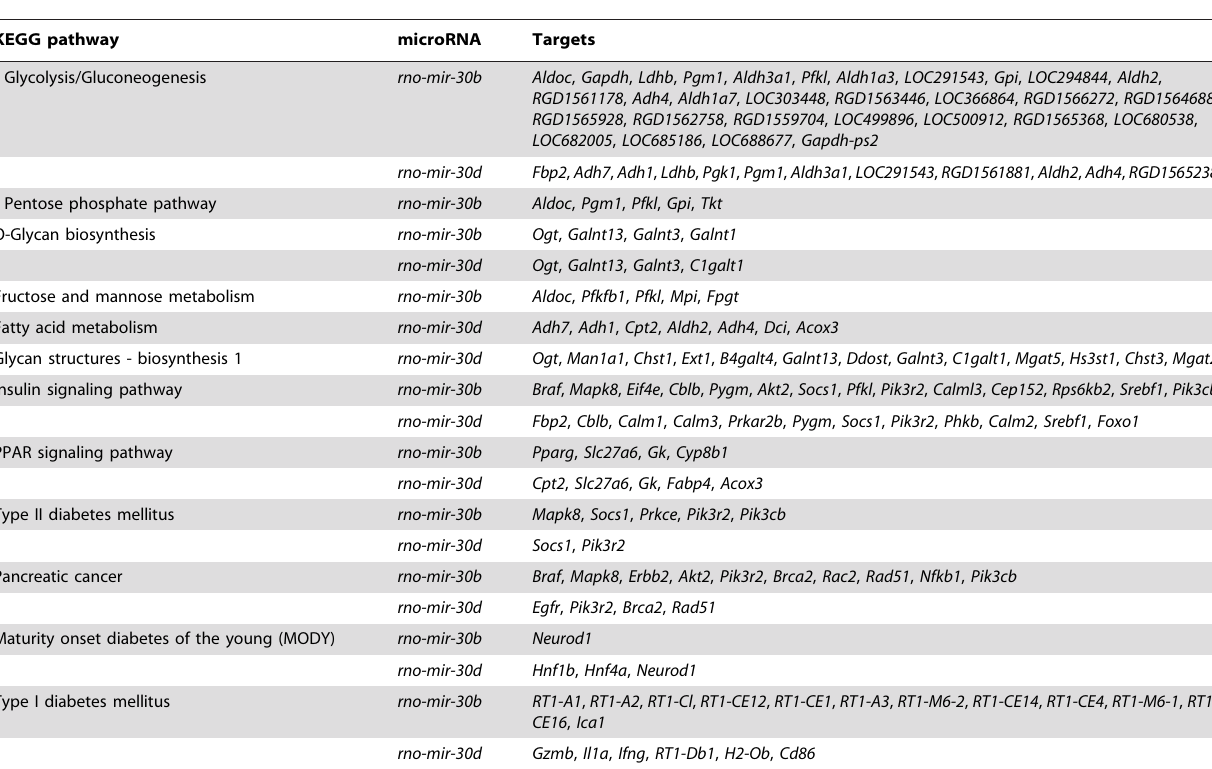
Table 4. The targets of rno-mir-30b and rno-mir-30d involved in diabetes-related